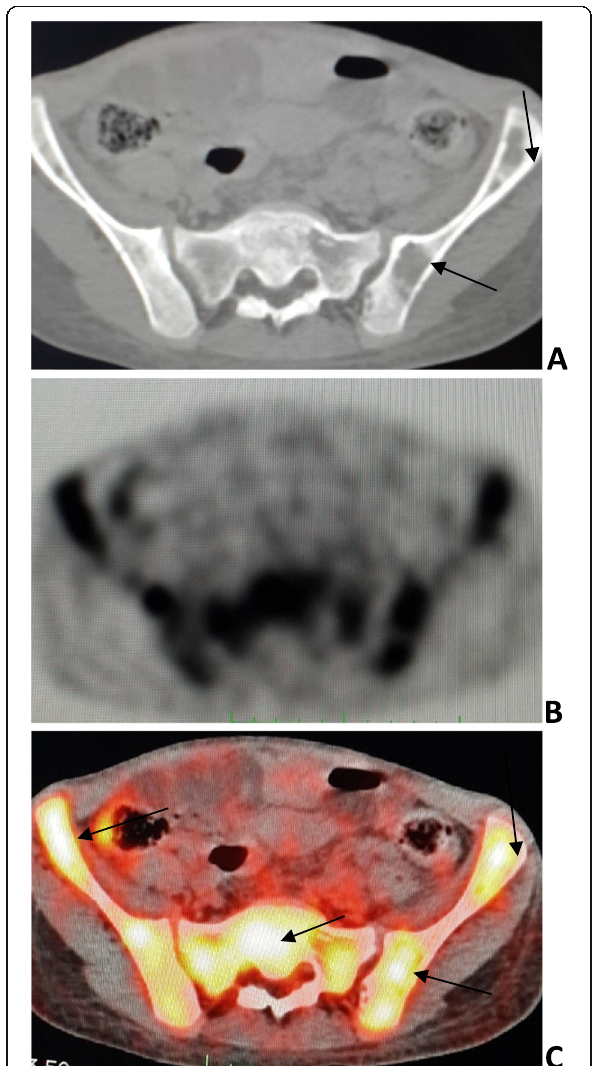
Fig. 4 A 55-year-old male patient with cervical nodal lesions proved to be NHL now presented with relative altered ossoeus density of the pelvic bones notably the left iliac bone with ill-defined lytic medullary areas (arrows in a ). b Corresponding axial PET and PET/CT ( c ) fused image showing diffuse FDG uptake notably at the anatomical site of the left iliac bone lytic areas (arrows in c